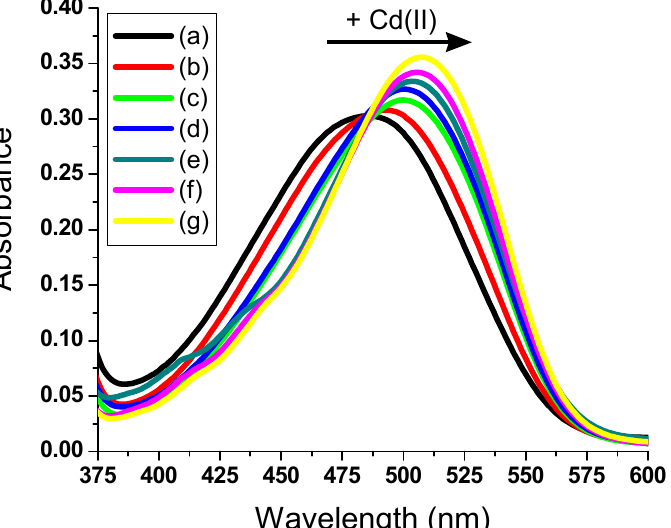
Figure 3. Absorbance spectra of hydrazone dye in CH 3 CN/aqueous (1:10) media of different metal ions ( top ), demonstrating color change between red (cadmium salt) and light orange (metal-free solution and other metal salt-containing solutions) ( bottom ). Table 2. Absorbance maxima of the hydrazone dye in CH 3 CN/aqueous (1:10) media of different metal salts.